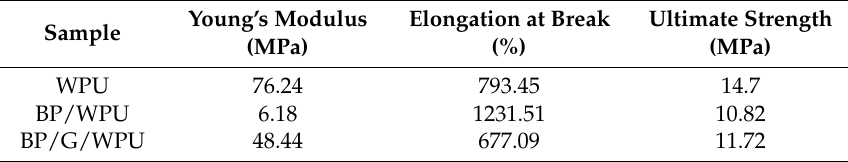
Table 3. The mechanical properties of Young’s modulus, elongation at break and ultimate strength recorded from the tensile tests